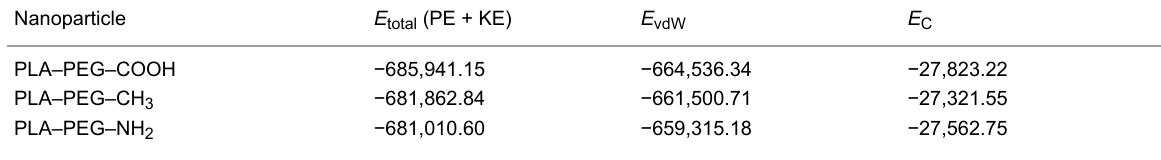
Table 1: Interaction energy (kcal/mol) between the PLA core and DSPE–PEG lipid